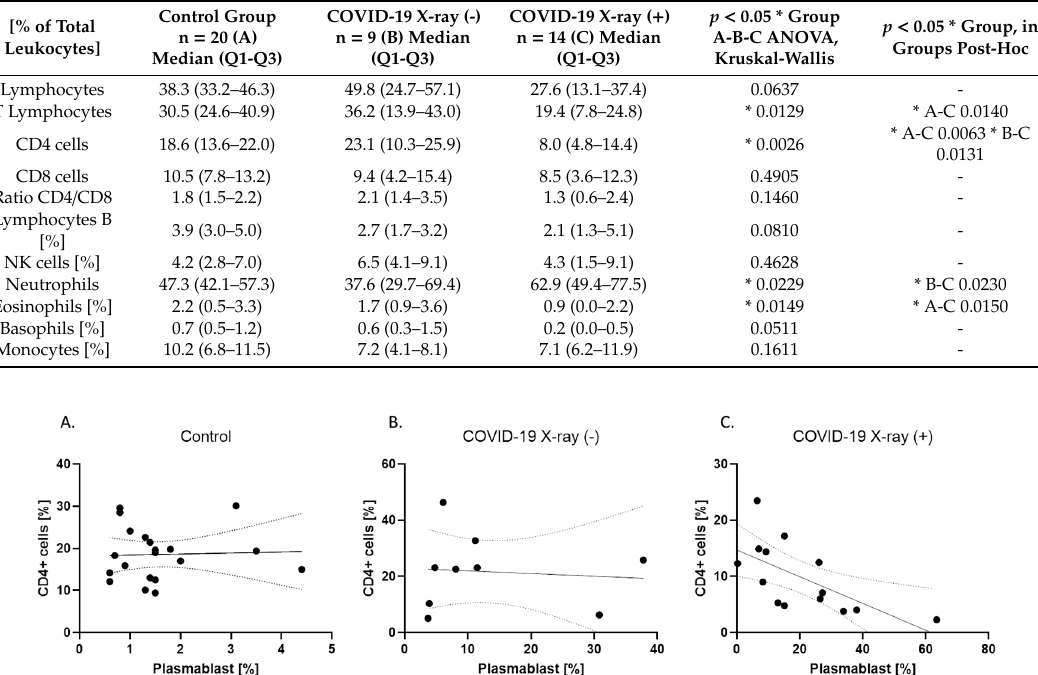
Figure A1. The correlations between proportion of plasmablasts and proportion of CD4+ cells in healthy patients ( A ), patients with COVID-19 without interstitial lesions on chest X-ray (( B ): COVID-19 X-ray ( − )) and patients with COVID-19 with interstitial lesions on chest X-ray (( C ): COVID-19 X-ray (+)).